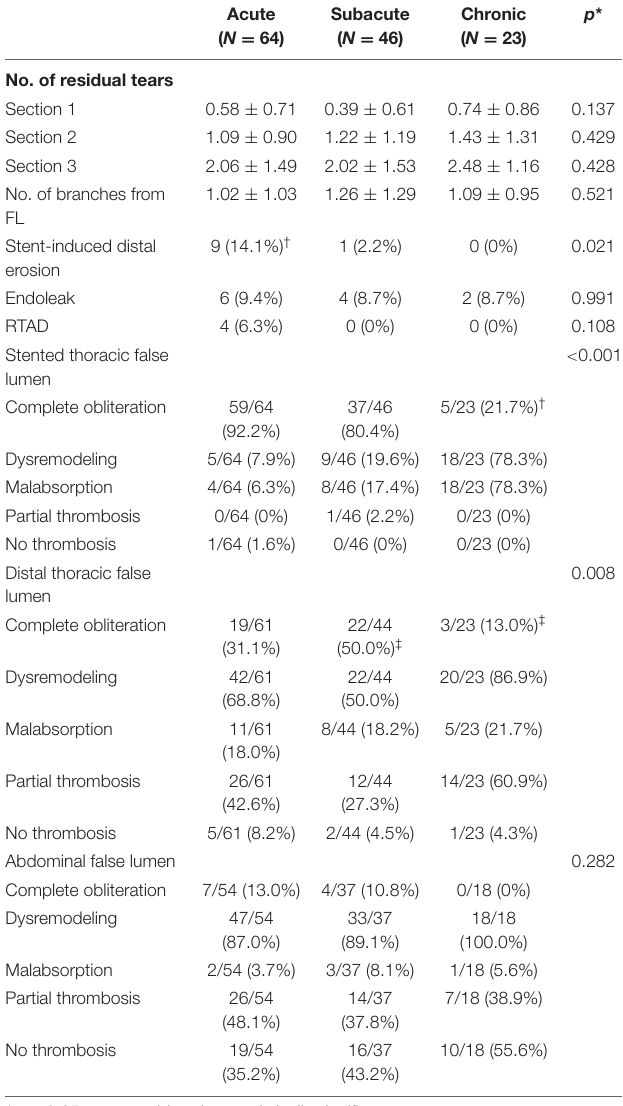
TABLE 3 | Imaging follow-up results and aortic